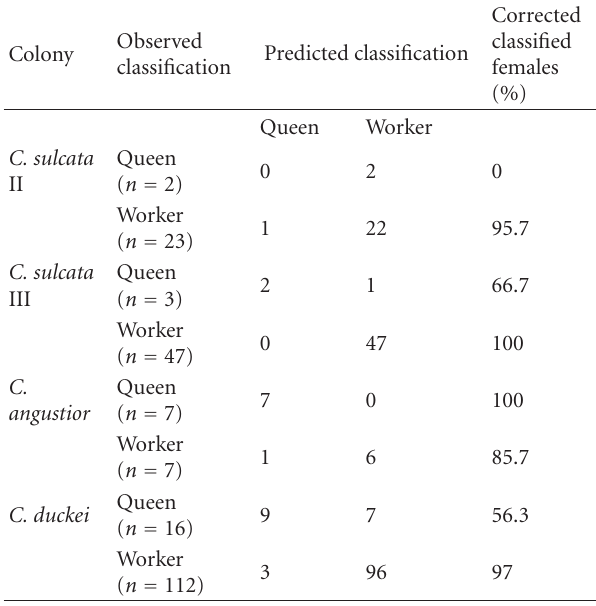
Table 4: Classification matrix queens, workers, and intermediate females in all analyzed colonies of genus Clypearia after discrimi- nant function